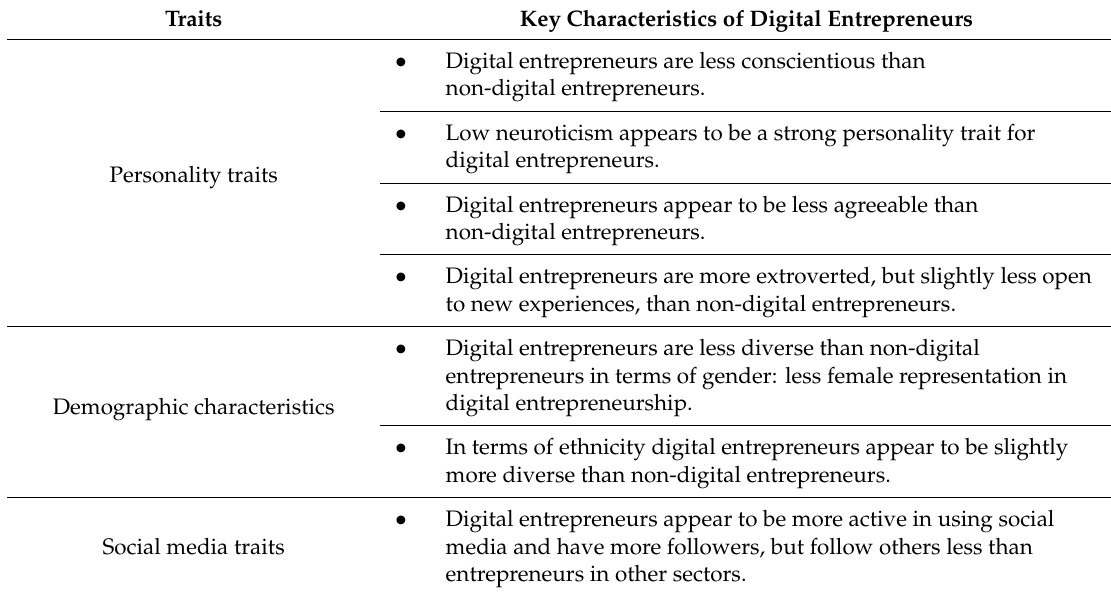
Table 5. A summary of